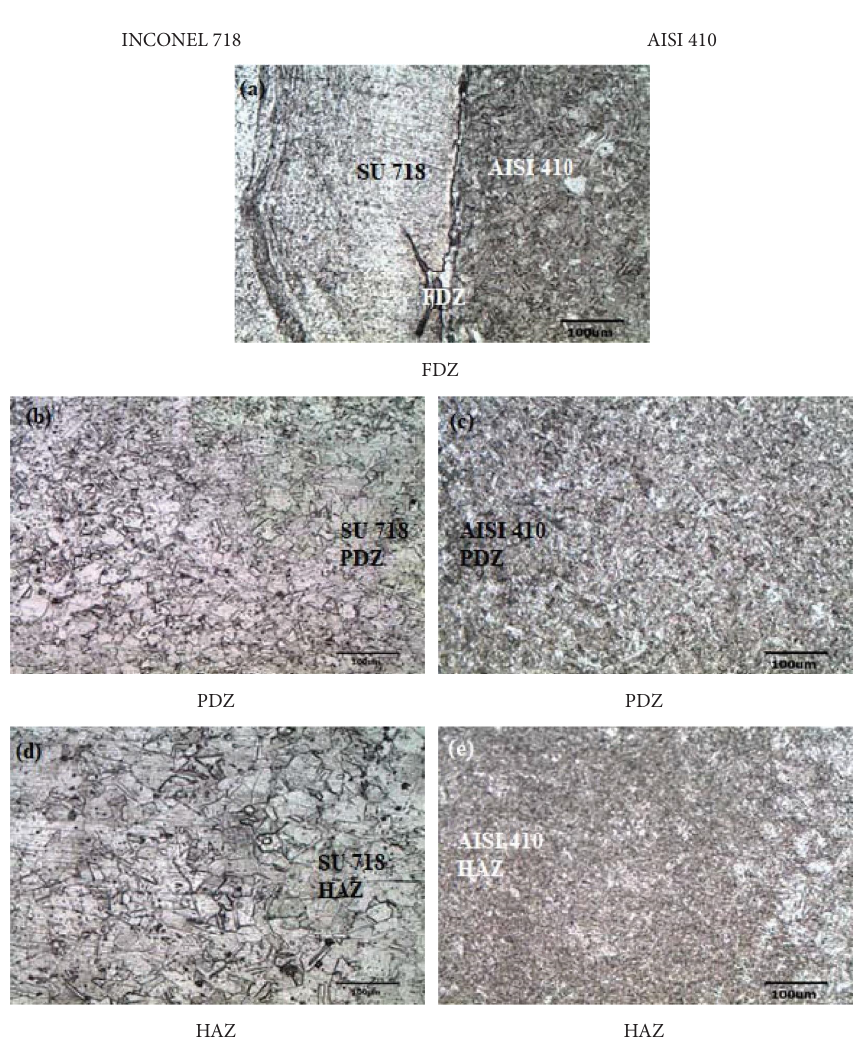
Figure 8: Dissimilar weld joint microstructure at